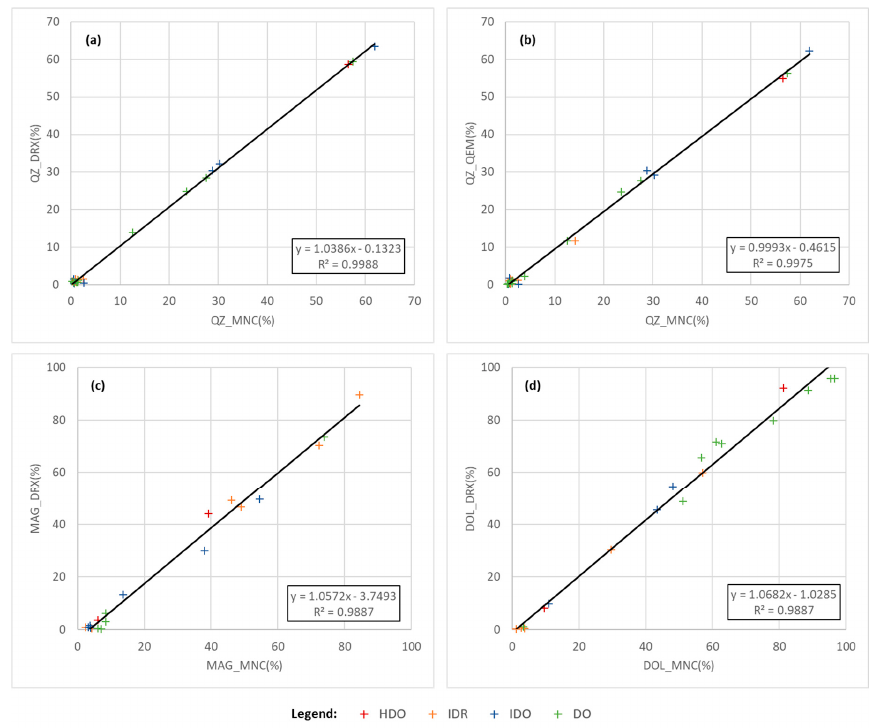
Figure 6. Scatter diagrams comparing mineral proportions of quartz ( a , b ), magnetite ( c ), and dolomite ( d ), calculated by MNC and XRD/Rietveld or QEMSCAN methods using unweathered (carbonate) samples.